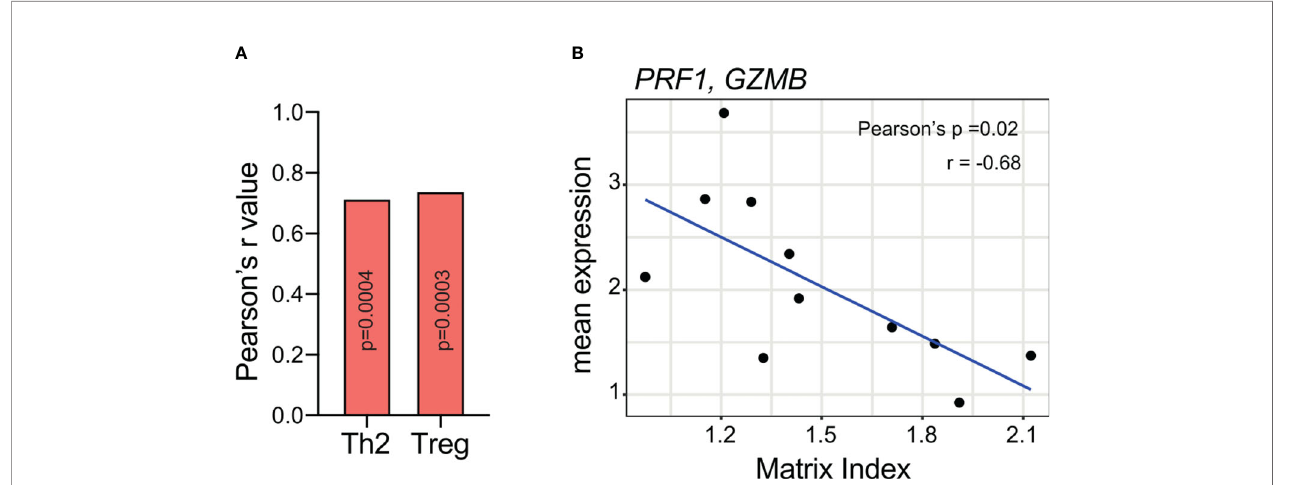
FIGURE 4 | A matrisome signature containing versican (A) positively correlates with Th2 and T regulatory expression and (B) negatively correlates with cytotoxic T cell markers. Meta-analysis on RNA-seq data from Pearce et al. (19). Analysis was completed on 33 patient samples of high-grade serous ovarian cancer omental metastasis. The matrix index refers to a signature of 22 matrisome genes identi fi ed in the paper with values determined from a ratio of upregulated and downregulated genes. Versican is one of six genes that were upregulated in tumours. Spearman rank correlation was used to compare matrix index values from immune cell expression (19, 79). P-values were FDR corrected using the Benjamini & Hochberg method. The average expression of PRF1 and GZMB (genes associated with cytotoxic T cells) was correlated to matrix index values from 11 poor prognostic patients using Pearson ’ s correlation. Th2, T helper cells; Treg, T regulatory cells; PRF1, perforin 1; GZMB, granzyme